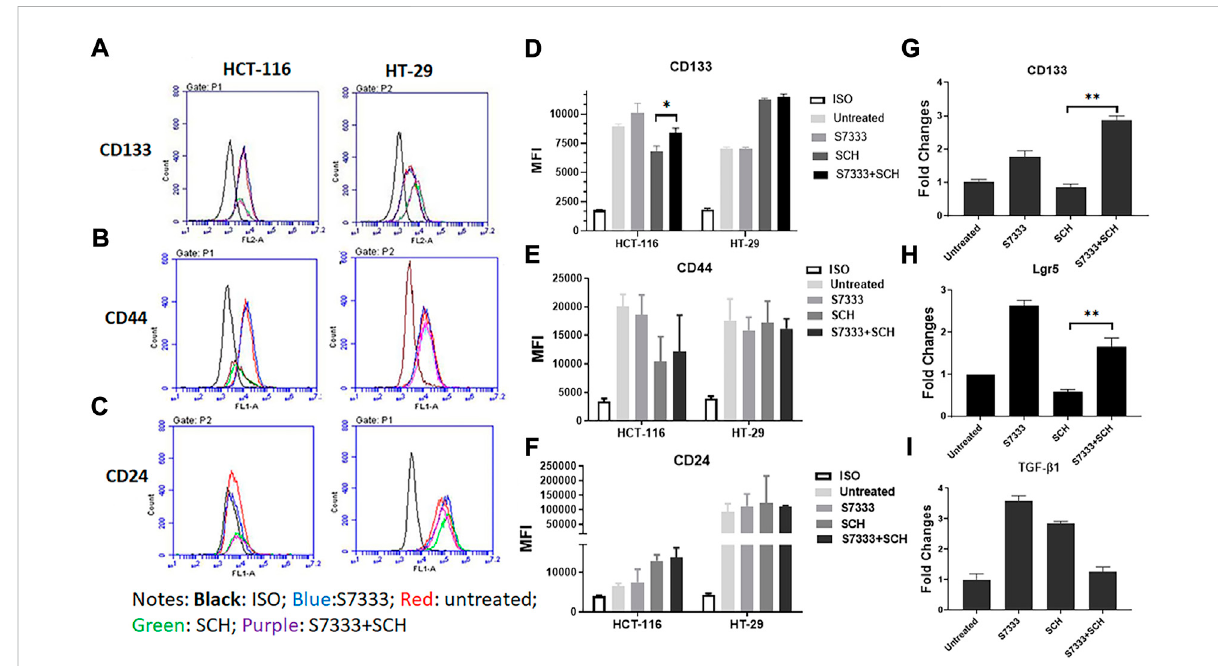
FIGURE 5 Blocking K-Ras mutation reduced the suppressive effect of SCH772984 treatment on cancer stemness markers in HCT-116 cells. The fl ow cytometry analysis of the expressions of surface stem markers CD133 (A) , CD44 (B) , and CD24 (C) in HCT-116 and HT-29 spheroids following the SCH772984treatmentafter the K-Ras G13D mutationhas been blocked. CD133 and CD44 expressions are increased after the combinationtreatment whereastheexpressionofCD133,CD44,andCD24didnotincreaseafterthesametreatmentinHT-29spheroids (D – F) .Real-timeqPCRresults show the stem gene CD133 (G) , Lgr5 (H) , and TGF- β 1 (I) expressions for HCT-116 cells. *: p < 0.05; **: p <